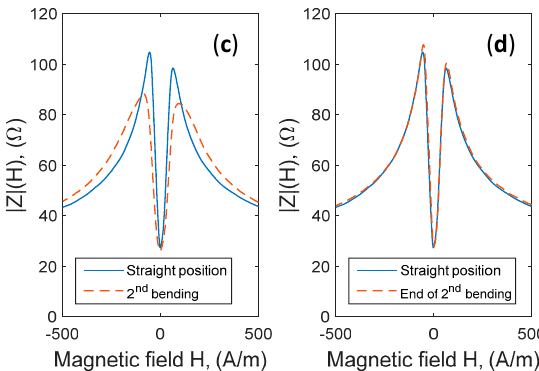
Figure 6. Reversibility and repeatability of the impedance curve, | Z ( H ) | , following two consecutive bending stresses. ( a ) Change in the modulus of the impedance, | Z ( H ) | , with a 1st bending stress applied; ( b ) Comparison between the modulus of the impedance after the relaxation of the bending stress (1st bending) and the initial straight position; ( c ) Change in the modulus of the impedance, | Z ( H ) | , with a 2nd bending stress; ( d ) Comparison between the modulus of the impedance after the relaxation of the bending stress (2nd bending) and the initial straight position.